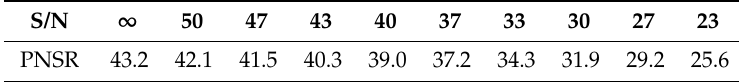
Table 9. Performances of No. 38 (5) under